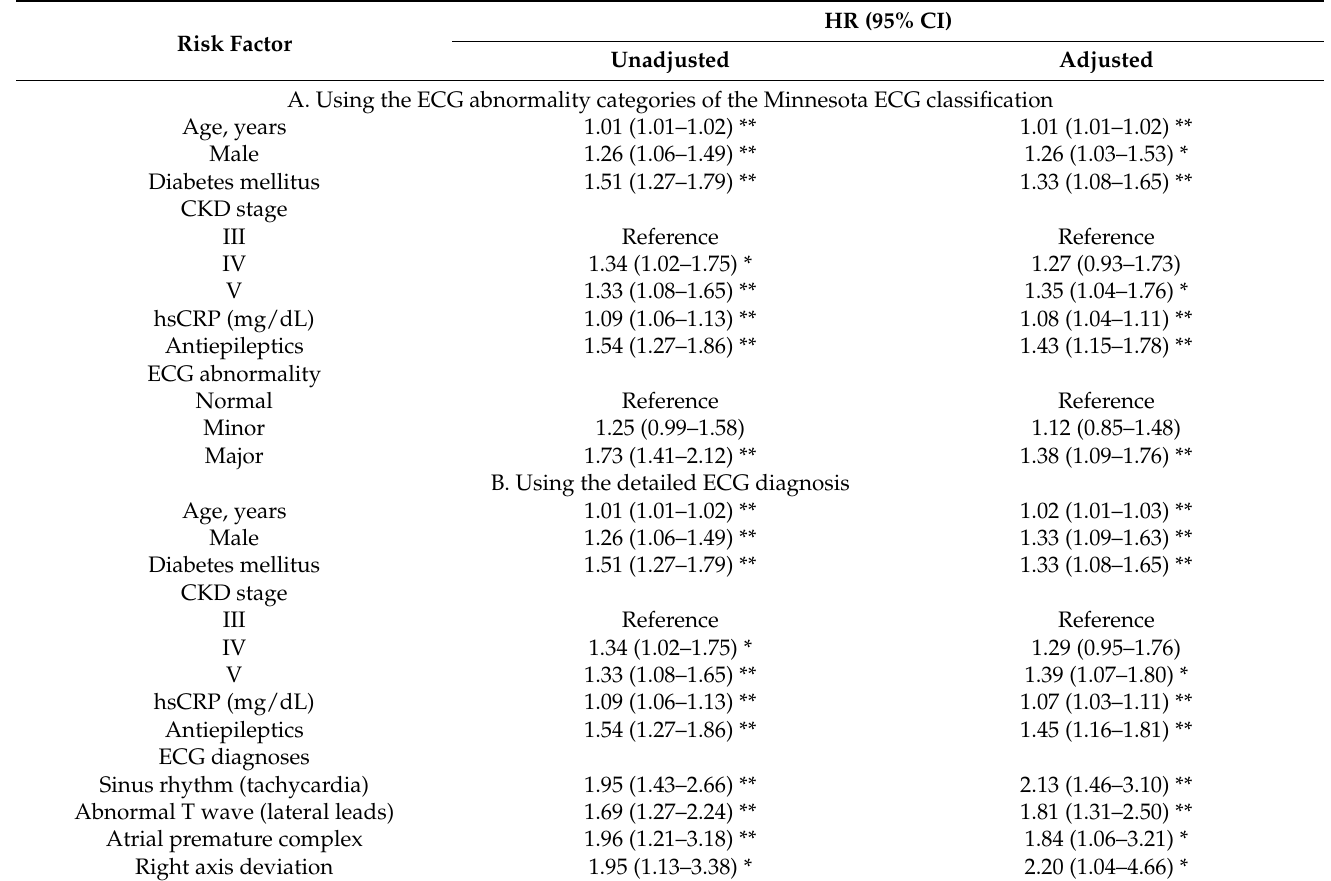
Table 4. Multivariable Cox regression analyses for